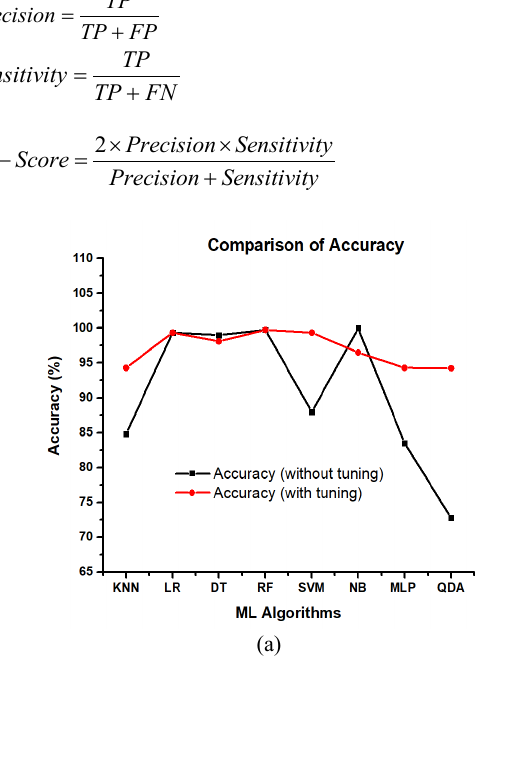
Table 7. Confusion Matrix for Naïve Bayes